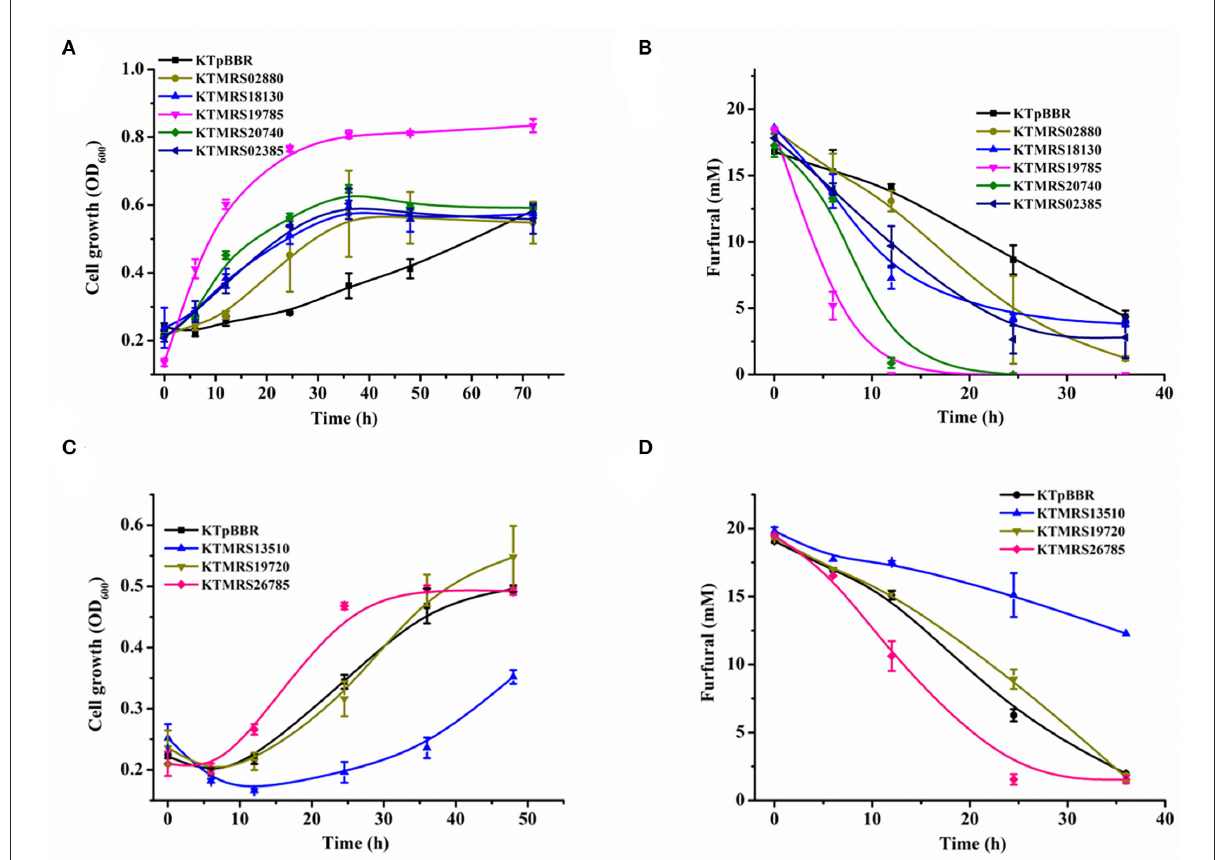
FIGURE3 Effects of mutations on growth and furfural tolerance of strains. The growth curve (A) and furfural conversion course (B) of strains overexpressing MRS02880, MRS18130, MRS19785, MRS20740, MRS02385, and the control (pBBR1MCS2); The growth curve (C) and furfural conversion course (D) of strains overexpressing MRS13510, MRS19720, MRS26785, and the control (pBBR1MCS2). All data are the mean value ± standard deviation of independent two